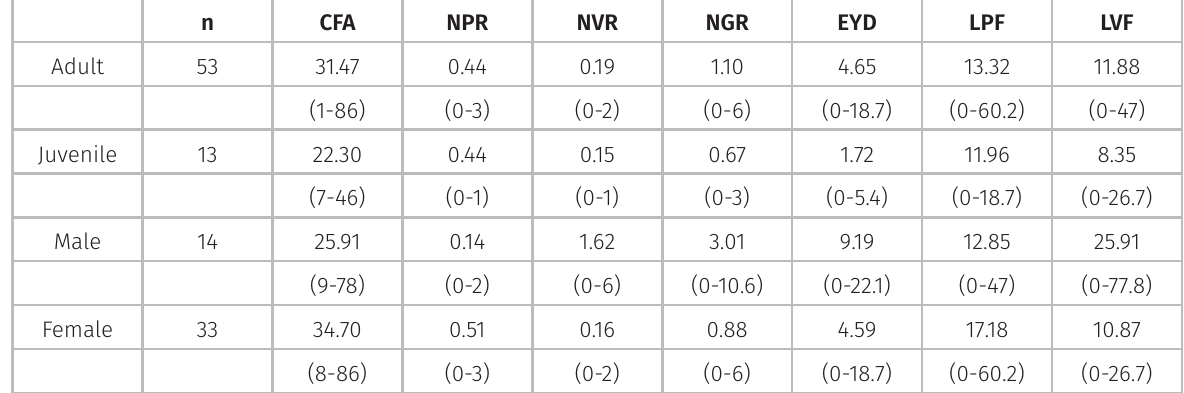
Table I. Mean values and range (between parentheses) of the levels of fluctuating asymmetry calculated through individual and composite indexes for the six morphological traits of Orthopristis ruber caught in Guanabara bay. CFA: composite index; NPR: number of pectoral fin rays; NVR: number of ventral fin rays; NGR: number of gill